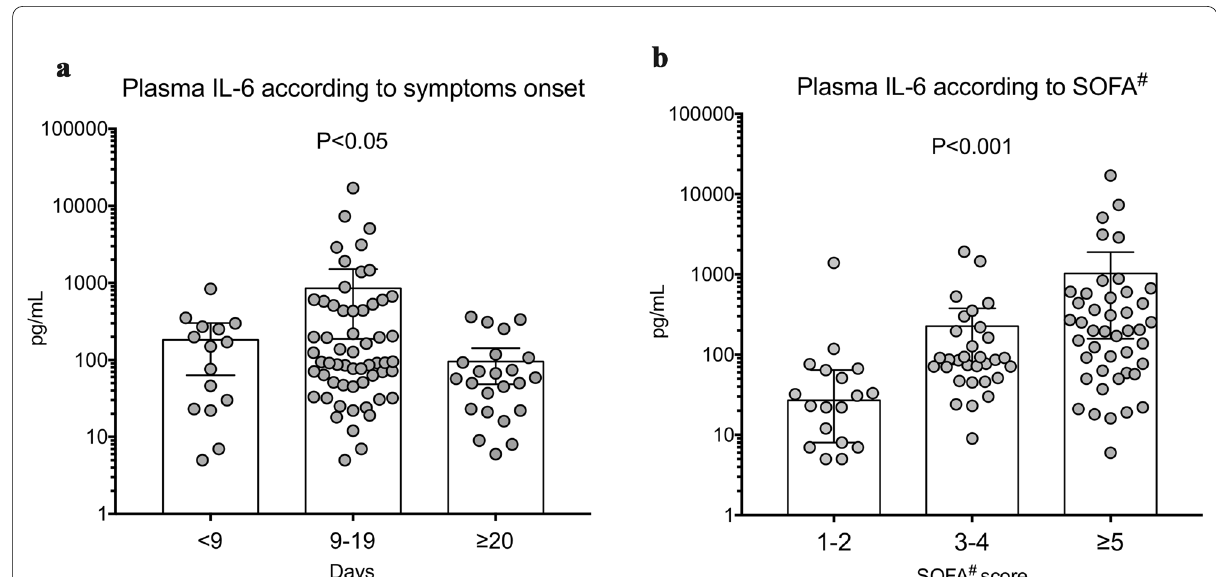
Fig. 1 A, Plasma levels of IL‑6 according to time between symptom onset and cytokine measurement (Kruskal–Wallis Test). B, Plasma levels of IL‑6 according to organ failure severity, evaluated using SOFA # score (SOFA score without neurological points). Data are expressed as median with 95%